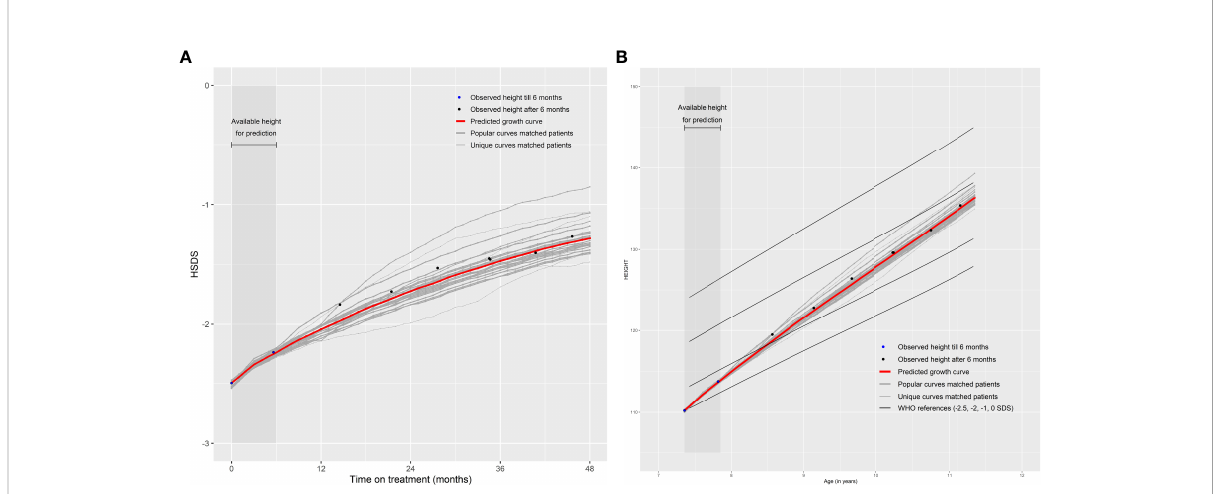
FIGURE 2 Good prediction of future growth comparing (A) observed HSDS with predicted HSDS and (B) observed height with predicted height, based on 25 matched